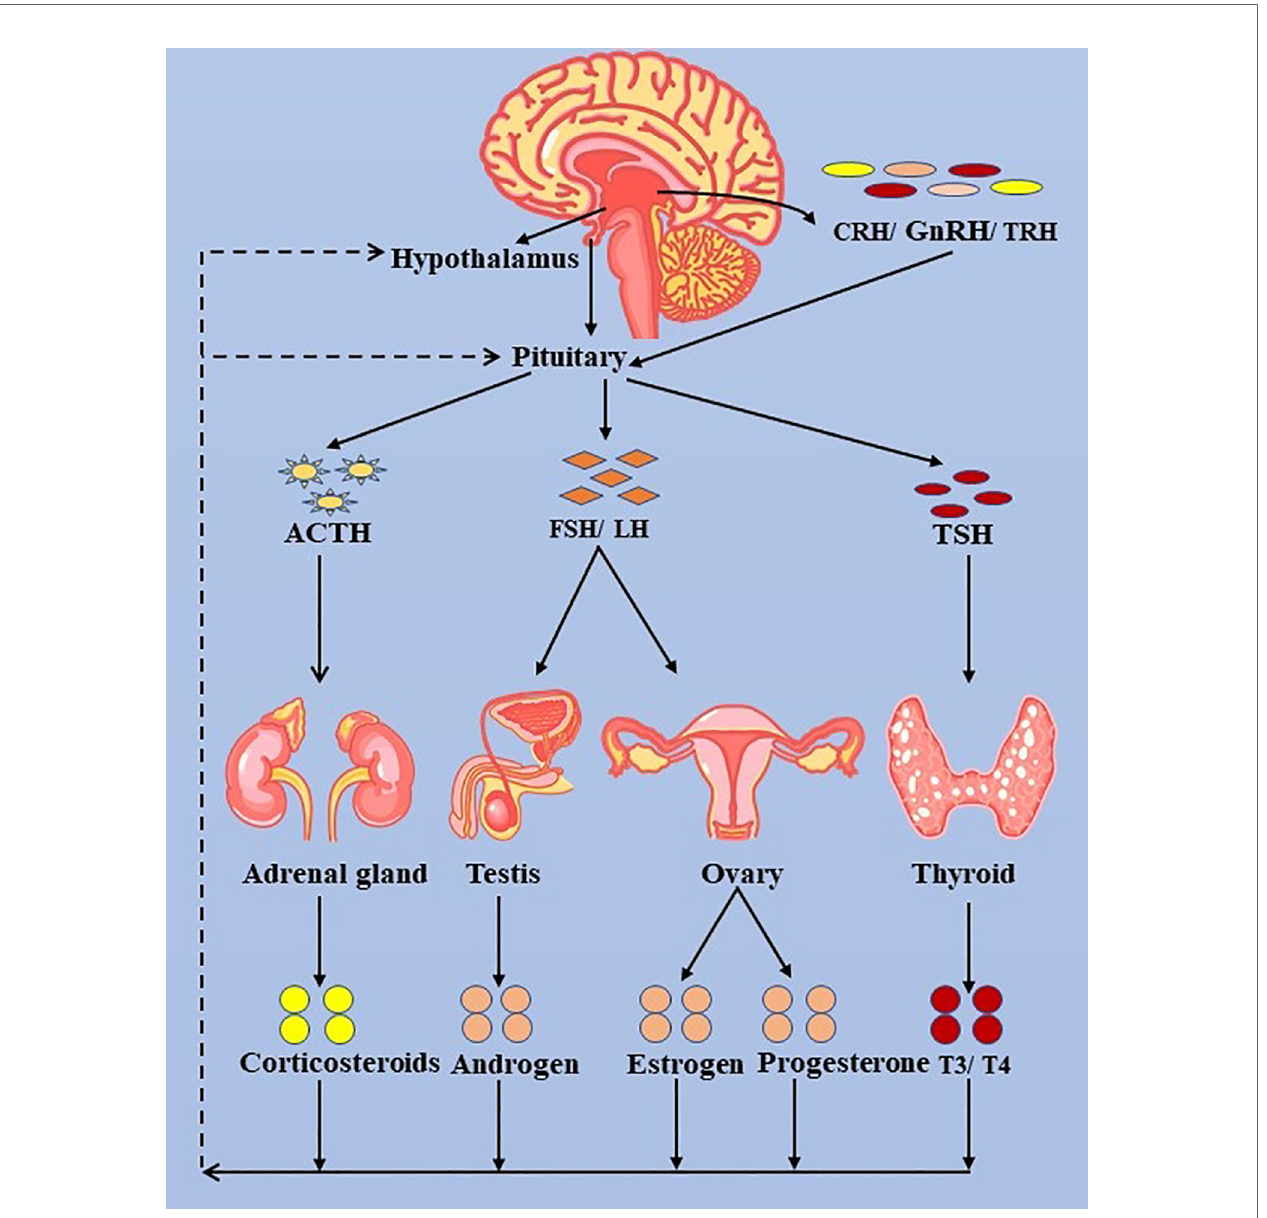
FIGURE 3 | The hypothalamus-pituitary-thyroid/adrenal gland/ovary/testis axis. ACTH, adrenocorticotropic hormone; LH, luteinizing hormone; FSH, follicle- stimulating hormone; FT3, free triiodothyronine; FT4, free thyroxine; TSH, thyroid-stimulating hormone; TRH, thyrotropin-releasing